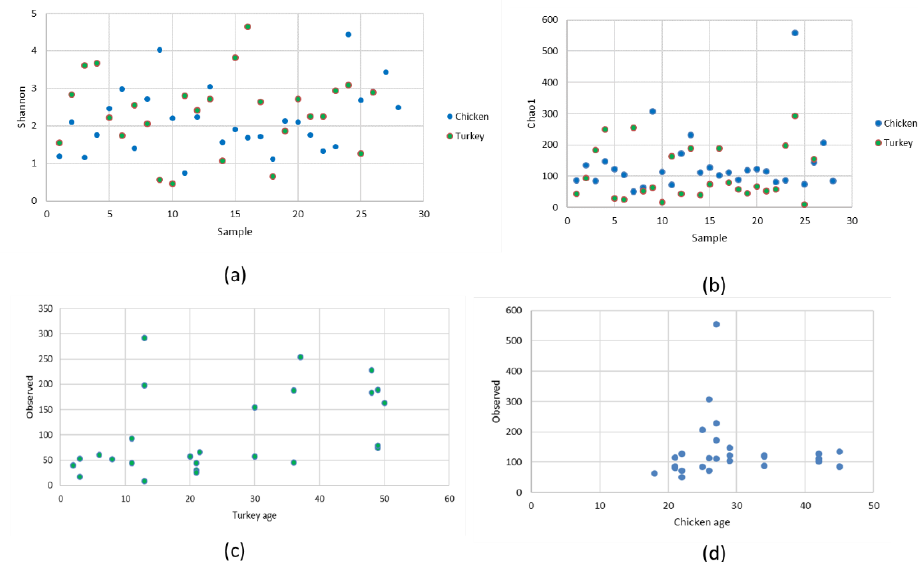
Figure 5. Alpha diversity comparison based on the: ( a ) Shannon index, ( b ) Chao1 index, ( c ) observed ASV in turkeys, and ( d ) observed ASV in chickens.